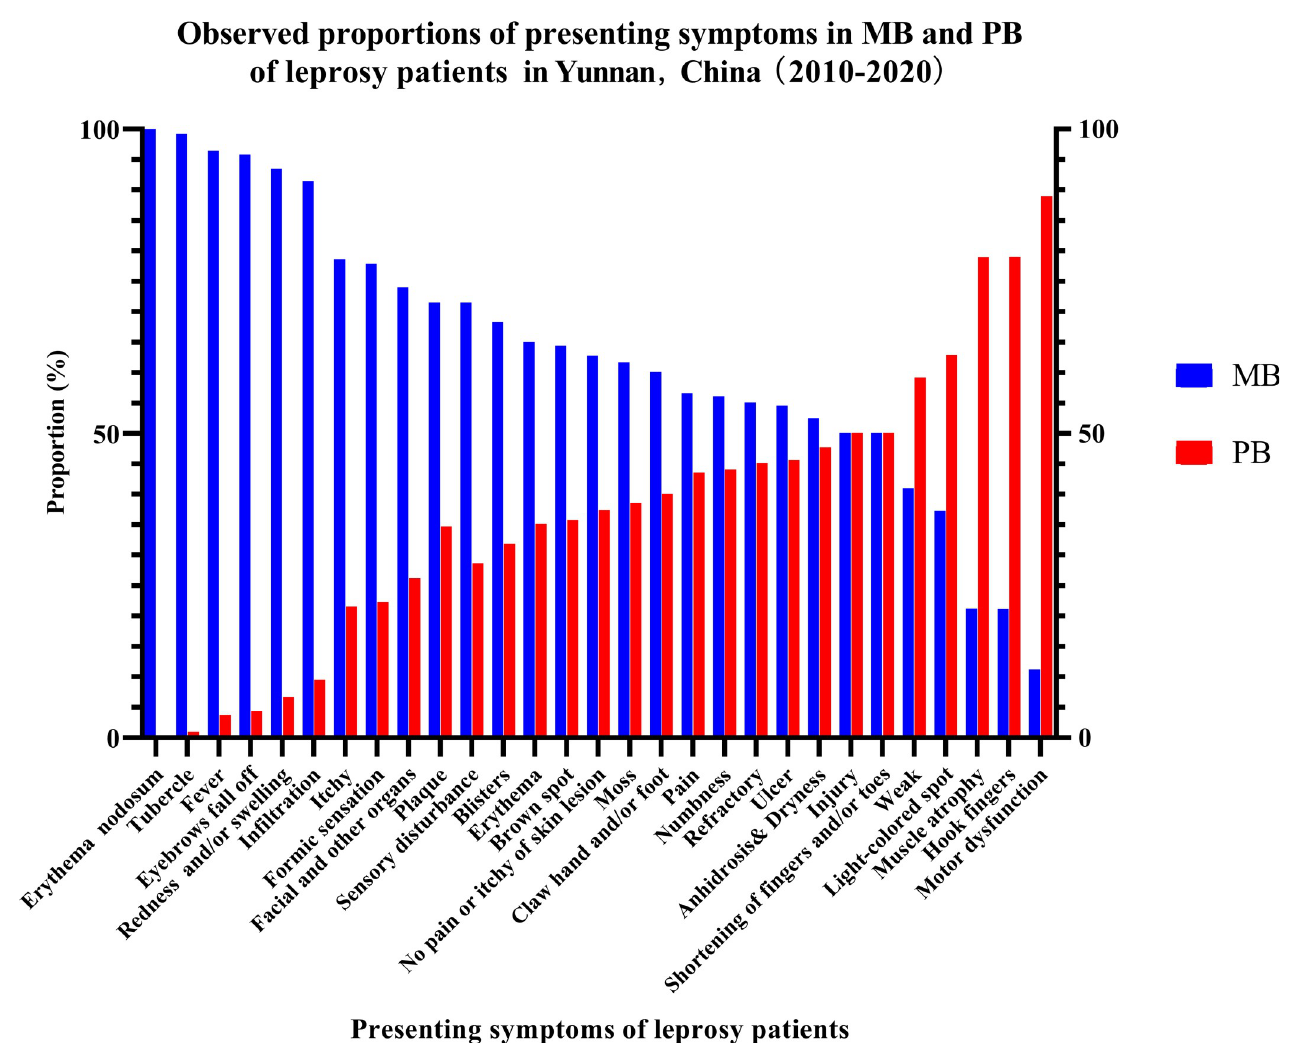
Fig 2. Observed Proportions of Presenting Symptoms in MB and PB Leprosy